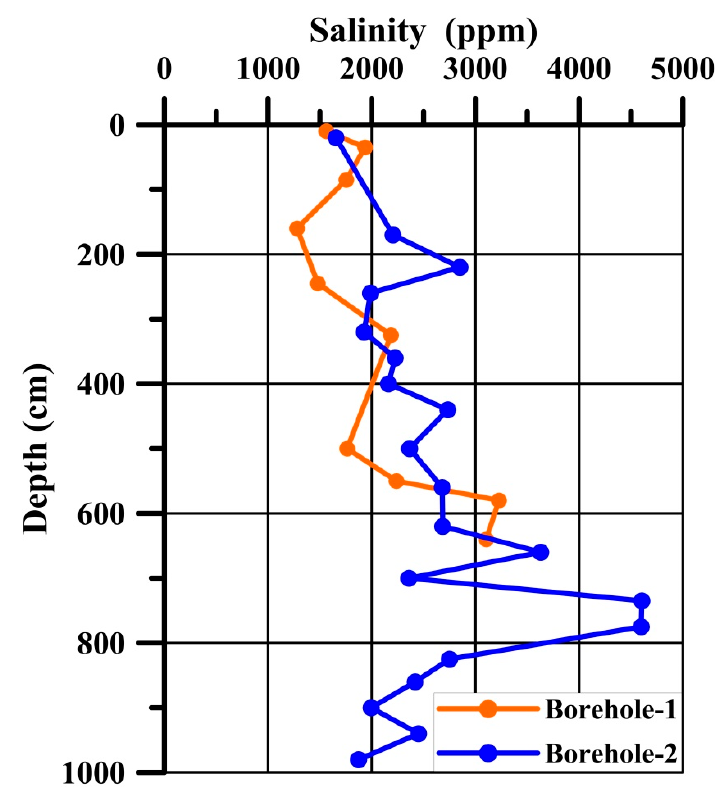
Figure 6. Sand salinity profiles of the two boreholes.